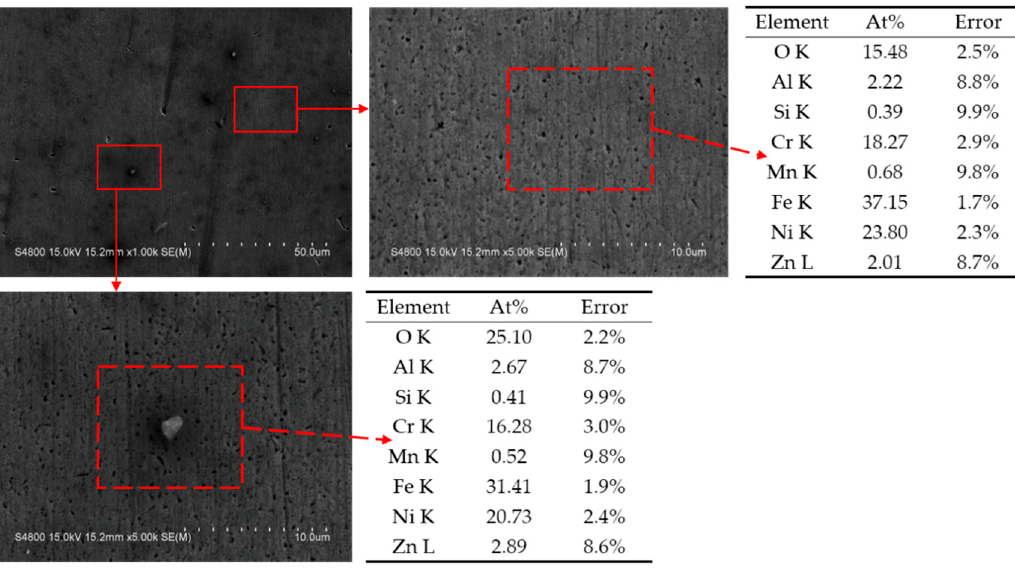
Figure 13. SEM images and the corresponding composition analysis of the passive film formed on In800 with the zinc–aluminum treatment.